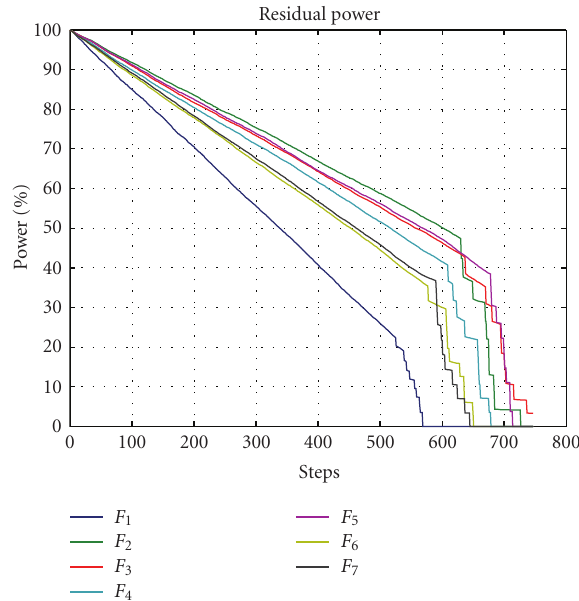
Figure 8: Percentage of network residual power during iterations for di ff erent criteria, defined in Table 2 (average results over 10